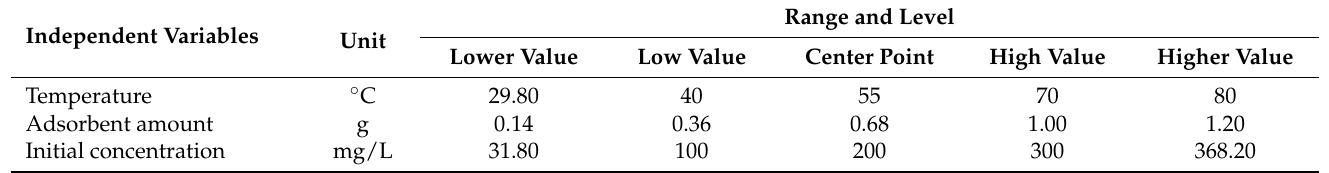
Table 1. Experimental ranges and levels of variables for adsorption